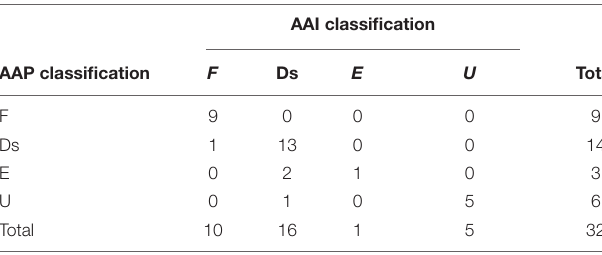
TABLE 3 | Attachment-classification overlap between the AAP and the AAI